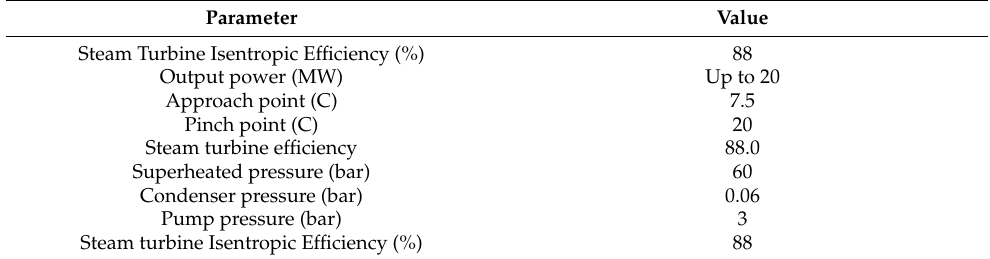
Table 3. Steam model with single HRSG assumption.